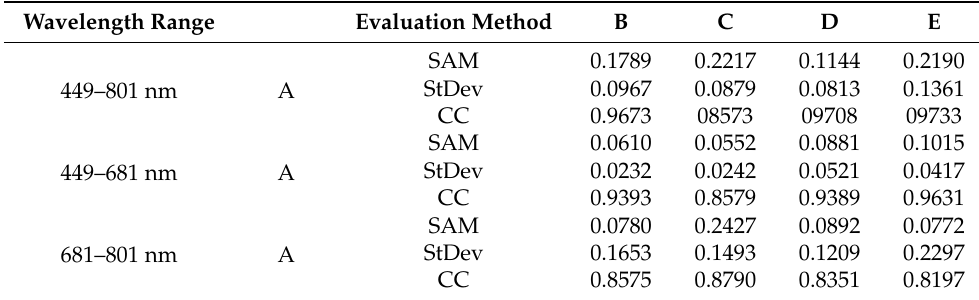
Table 1. Comparison of Spectral Similarity in Visible Light Band.